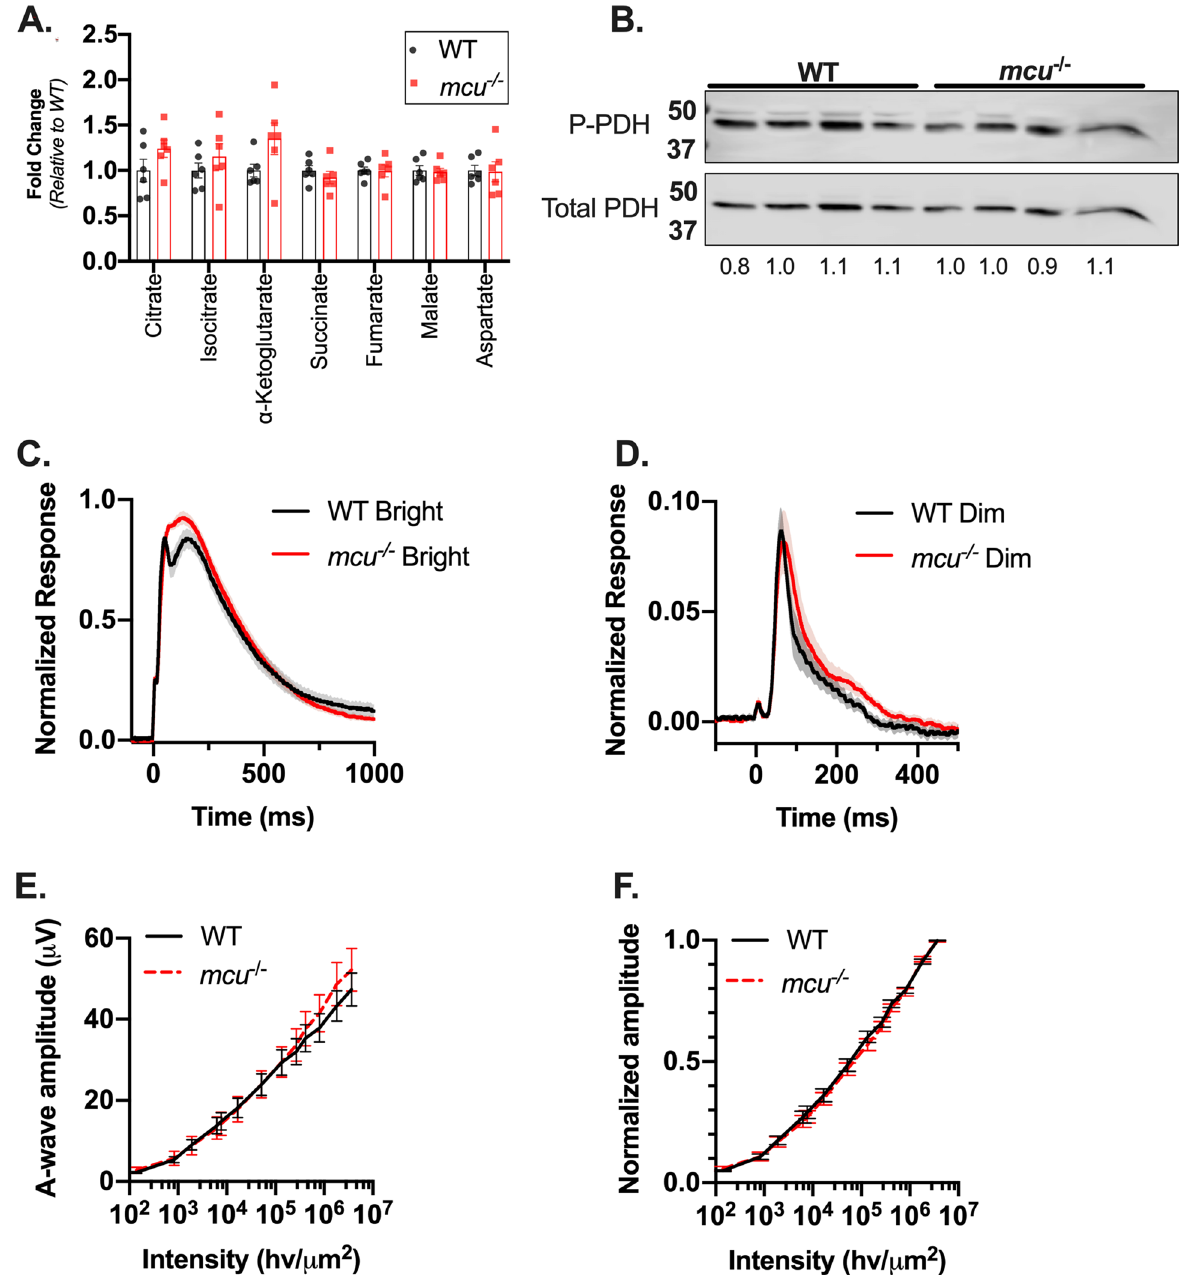
Figure 3. Retinas from global mcu -/- zebrafish have normal morphology, metabolism, and photoresponse. ( A ) Total TCA cycle metabolite levels in mcu -/- zebrafish retinas relative to WT. Zebrafish were dark-adapted for 18 h and retinas were dissected under red light. α-ketoglutarate levels trend higher in mcu -/- zebrafish retinas, although they are not significantly different than WT (1.4 ± 0.5-fold higher in mcu -/- retinas, p = 0.09 using Welch’s t test, mean ± standard deviation is reported, n = 6 WT and 6 mcu -/- retinas from 3 different fish each). ( B ) P-Pdh and total Pdh immunoblot from dark-adapted WT and global mcu -/- zebrafish retinas. 15 µg of protein was loaded in each lane. Quantification of the P-Pdh/Pdh ratio of each sample relative to the average WT P-Pdh/Pdh ratio is shown below each lane (n = 4 WT and 4 mcu -/- retinas from 4 different fish each). ( C ) Ex vivo ERG a-wave responses from WT and mcu -/- zebrafish retinas. Cone responses were isolated using DL-AP4 (40 µM) and CNQX (40 µM) and normalized to R max (the maximum response at the brightest light intensity). Bright flash stimulus intensity is 3,650,000 photons µm −2 and 2–23 ms in duration. The mean is reported and the shaded region indicates standard error (n = 21 retinas from 12 WT fish and 21 retinas from 13 global mcu -/- fish). ( D ) Ex vivo ERG a-wave responses from WT and mcu -/- zebrafish retinas under dim flash stimulus under the same conditions as ( C ). ( E ) a-wave response amplitude data plotted as a function of stimulus intensity (photons μm -2 ) of WT and global mcu -/- retinas from experiments shown in ( C ) and ( D ) (Bars indicate standard error). ( F ) Normalized response amplitude data for experiments shown in ( C ) and ( D ) indicate that sensitivity is not changed in global mcu -/- cones (Bars indicate standard